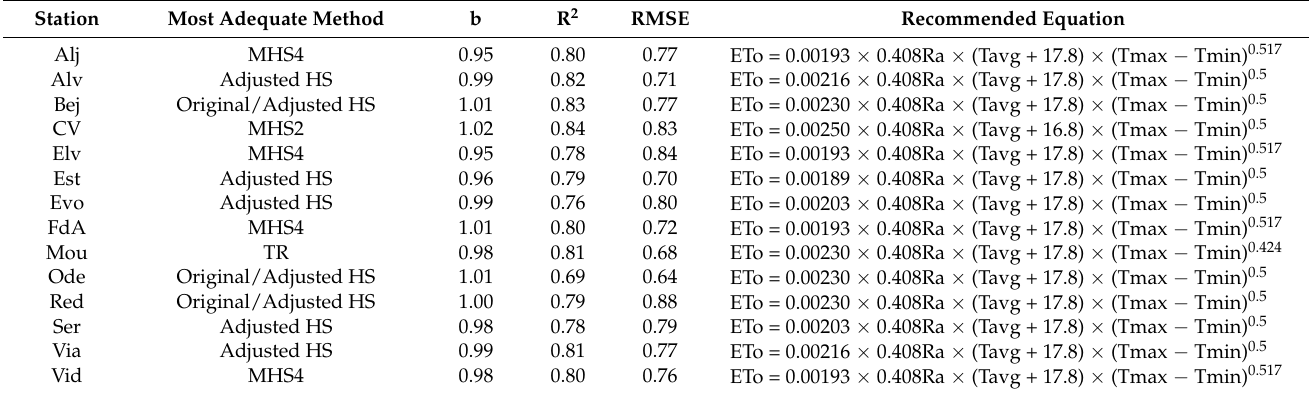
Table 6. Accuracy of ETo estimations using temperature-based methods (k Rs